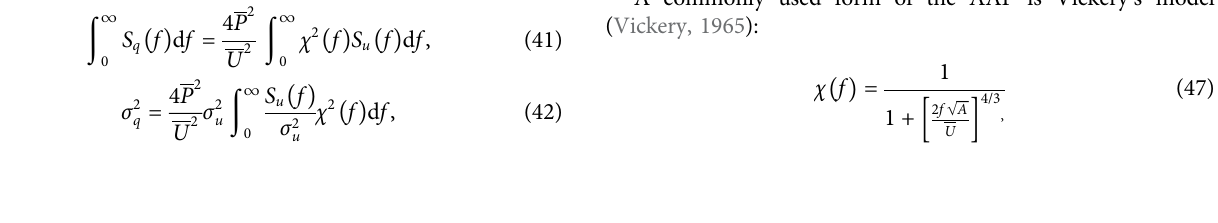
Frontiers in Built Environment |